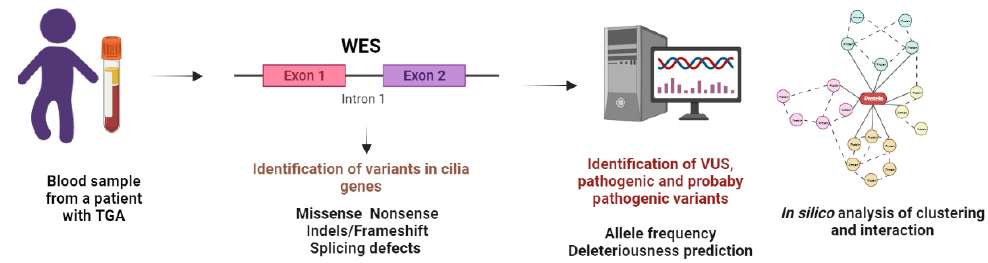
Figure 1. Genetic analysis abnormalities flow chart in patients with transposition of the great arteries. WES: Whole exome sequencing. VUS: Variants of Uncertain Significance.